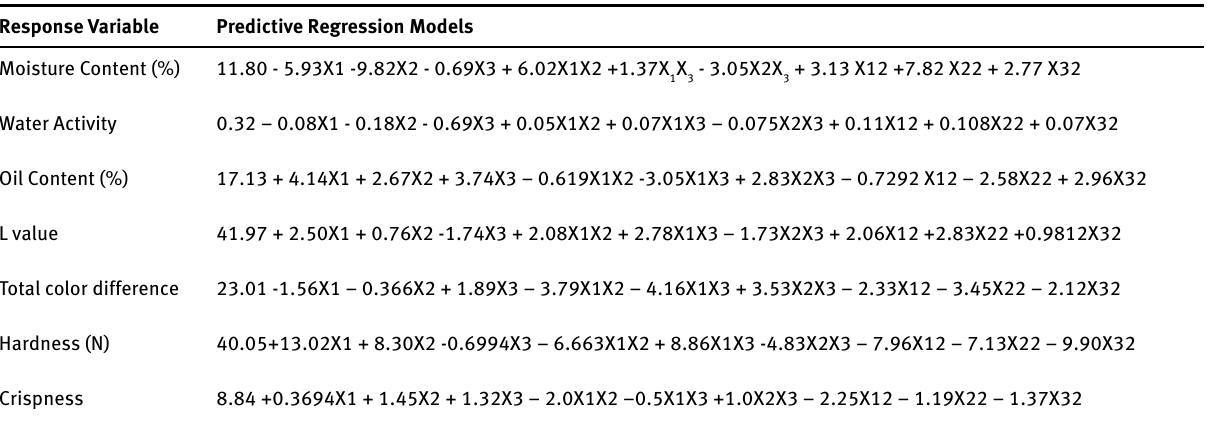
Table 2 : Predictive regression models for moisture content, water activity, oil content, L value, total color difference, hardness and crispness of sweet potato chips